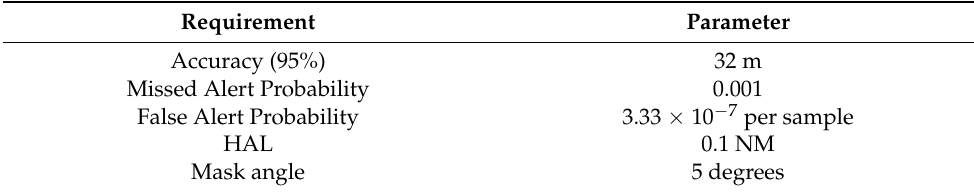
Table 3. Performance requirements for the